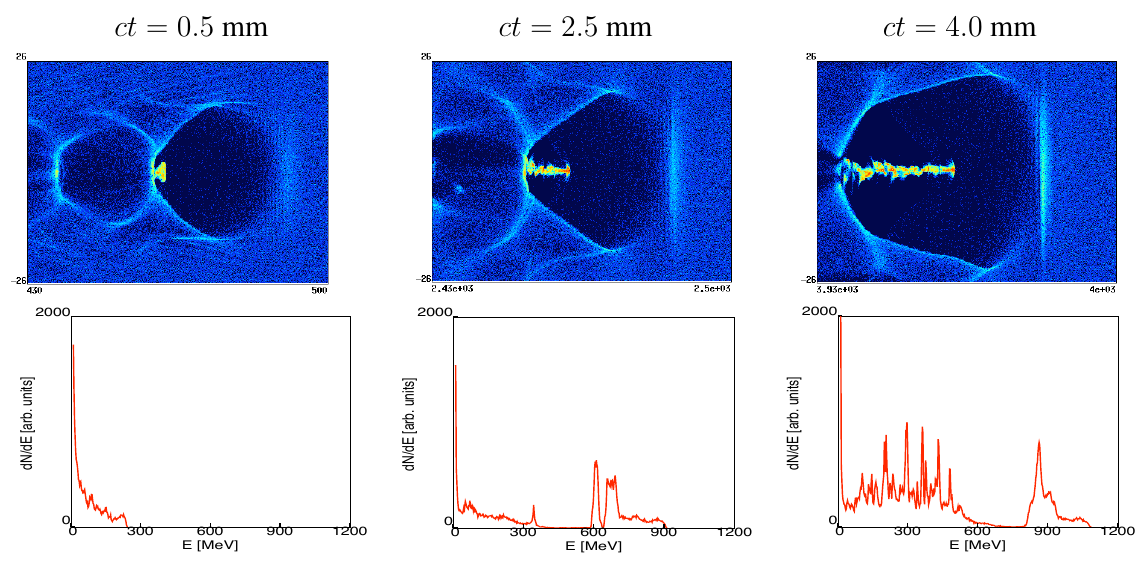
Figure 13. Energy spectrum of the accelerated electrons as obtained from the 3D PIC simulation for the SITE at three different propagation length inside the